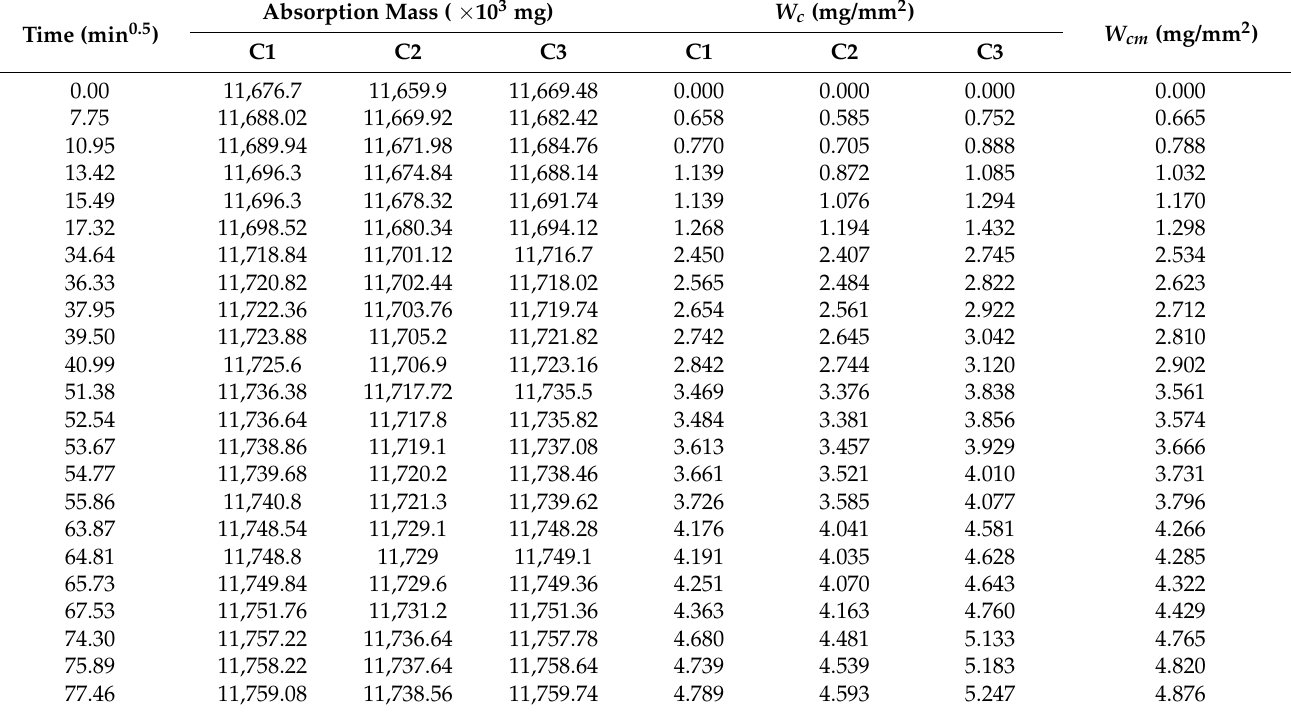
Table 13. Results of water absorption tests by capillarity obtained for the reference mixture REF2.